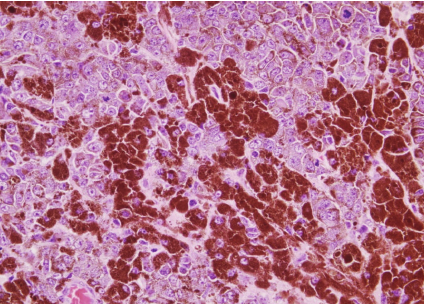
Figure 2: H&E stain, × 400, sheets of moderately large polygonal cells with round to oval pleomorphic nuclei, dispersed chromatin with mitotic activity (8–10/10 high power field).